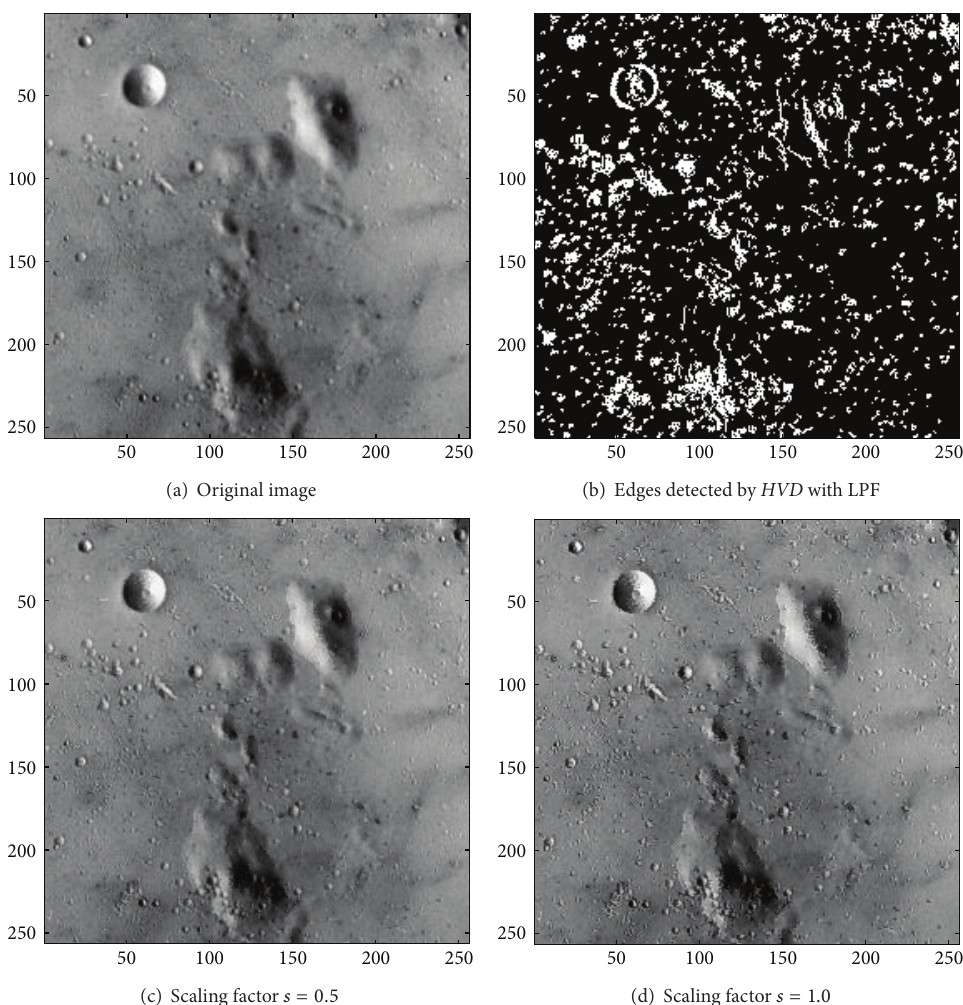
= 16 for HVD .(a)Theimage“Moonsurface”(256 × 256greyimage).(b)Edgesdetectedby HVD withLPF.(candd)Sharpened Figure15: 𝜃 eth results by HVD with scaling factors 0.5 and 1.0 , respectively.